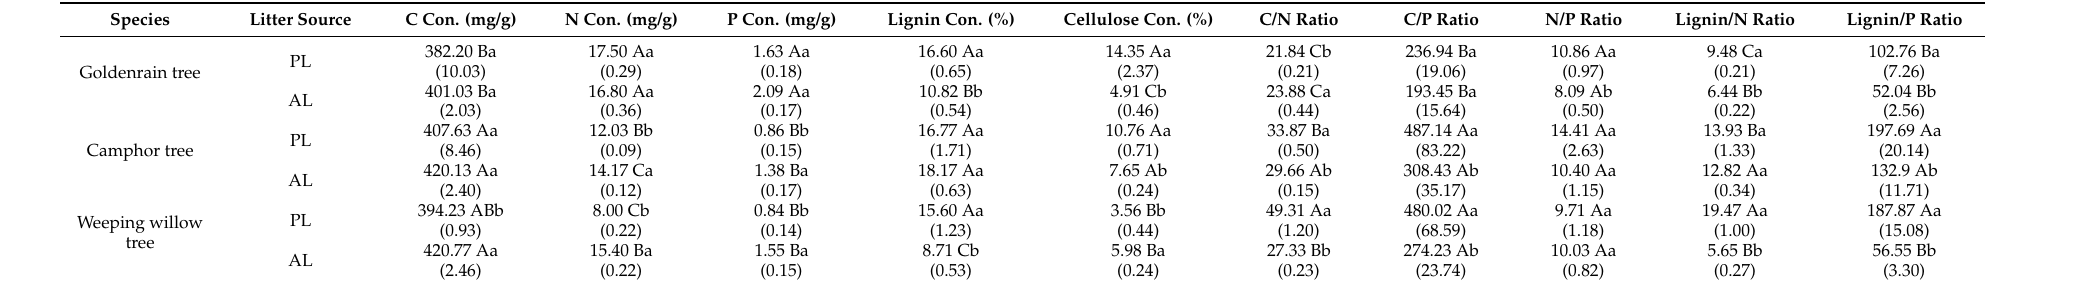
Table 1. Mean initial elemental concentrations and substrate quality of foliar litter from three species of subtropical urban forest at the start of the decomposition experiment. Standard errors are in parentheses. Different capital letters indicate significant differences between different tree species ( p < 0.05). Different lowercase letters indicate significant differences between different sources of foliar litter ( p <